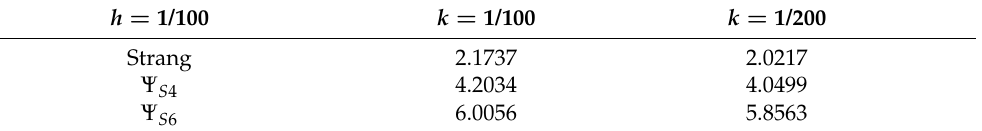
( error ( k ) /error ( k /2 )) for three symmetric-splitting methods with h = 1/100. Table 2. Evolution of log 2 h = 1/100 k = 1/100 k =